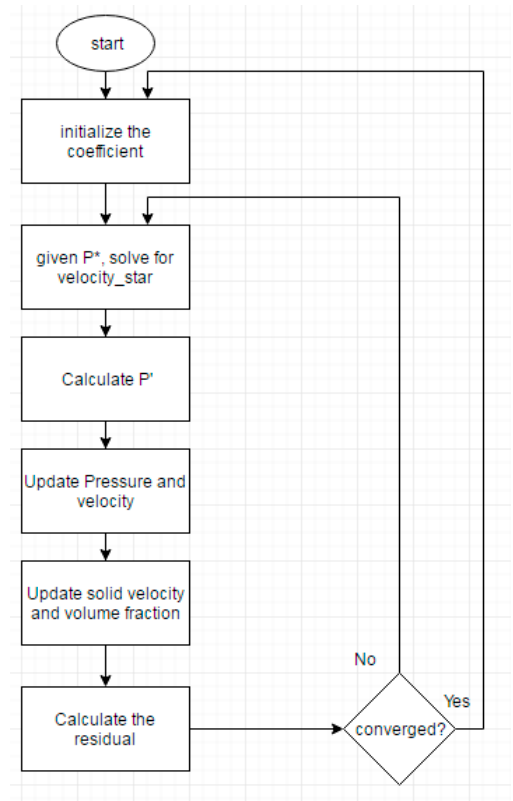
Figure 1. Multiphase Flow with Interphase eXchanges (MFiX) solution algorithm